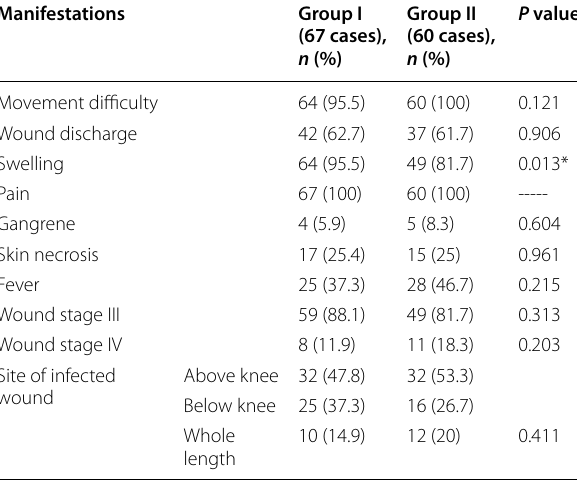
Group I used NPWT, Group II conventional wound care *Statistical significance at p <